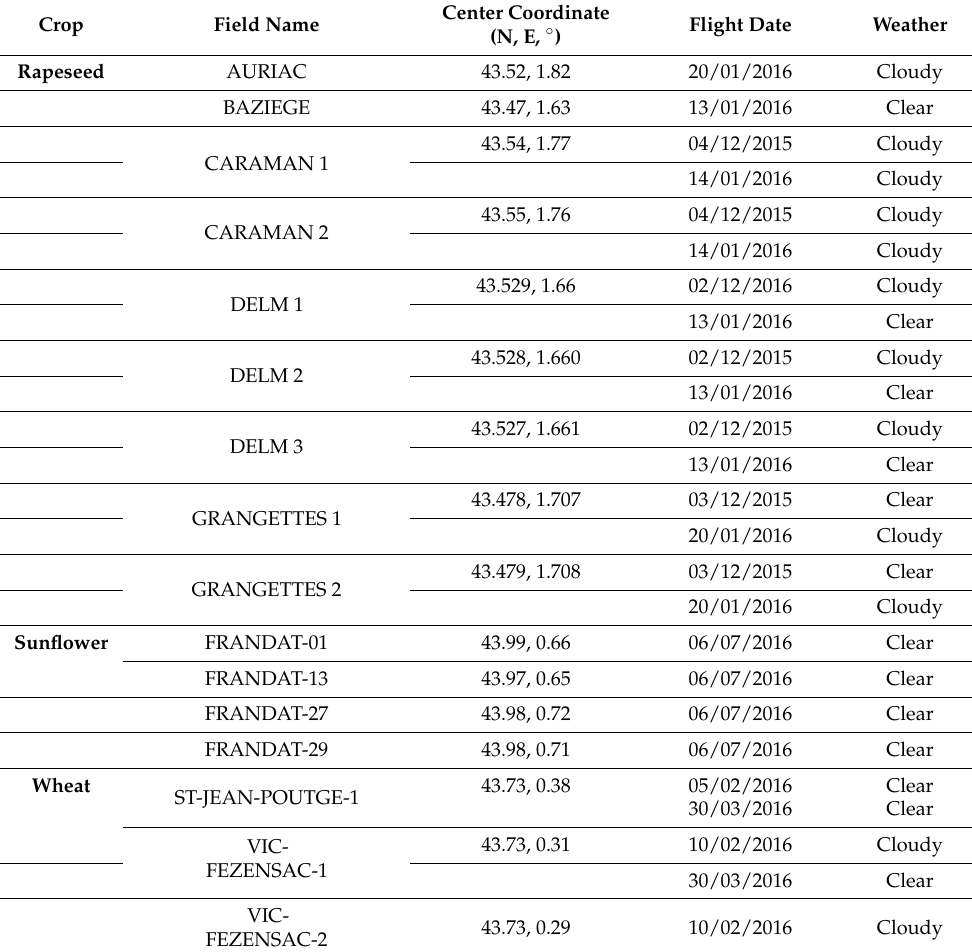
Table 1. The names, coordinates, dates and weather of the UAV flights for rapeseed, sunflower and wheat